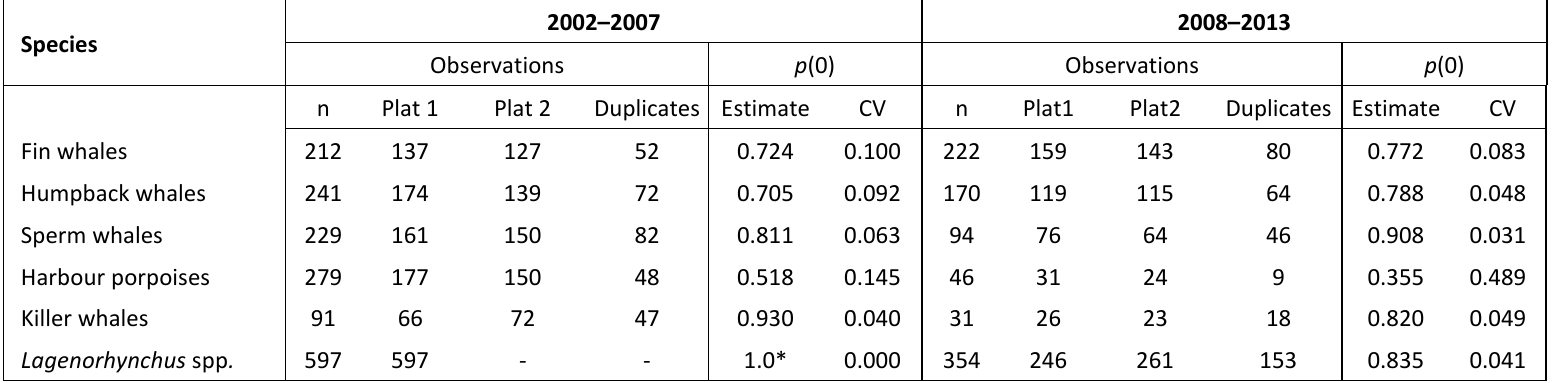
Table 4. Estimated p (0) for each species showing the total number of sightings (n), sightings by platform, and duplicates. Species